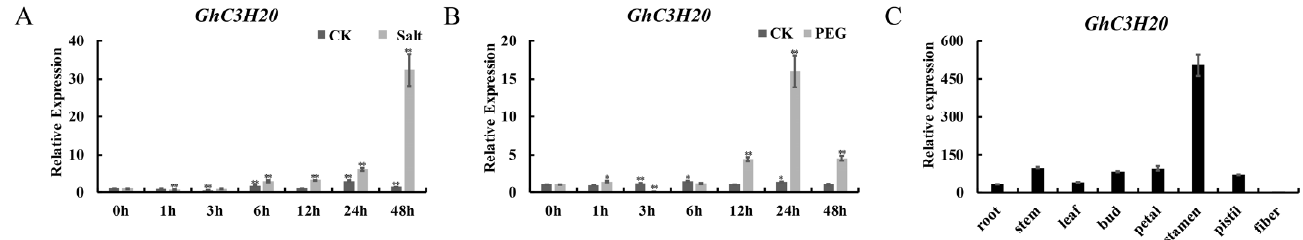
Figure 2. Expression pattern analysis of GhC3H20 under 200 mM NaCl and 20% PEG treatment and in eight cotton tissues (root, stem, leaf, bud, petal, stamen, pistil, and fiber) in cotton. ( A ) Expression pattern analysis of GhC3H20 gene in roots under ddH 2 O (CK) and 200 mM NaCl treatments. ( B ) Expression pattern analysis of GhC3H20 gene in leaves under ddH 2 O (CK) and 20% PEG treatments. ( C ) Expression pattern analysis of GhC3H20 gene in eight tissues. The error bars represent standard deviations of three technical replicates (* p < 0.05, ** p < 0.01, Student’s t -test).